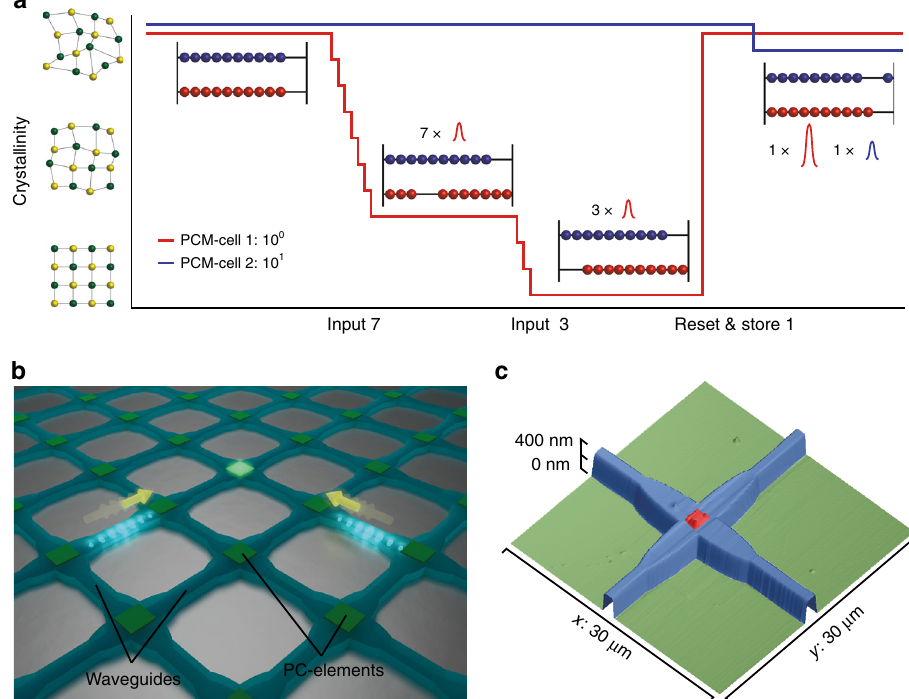
Fig. 1 All-optical arithmetic using phase-change nanophotonics. a Schematic of the operation principle of the photonic abacus. Two phase-change cells are switched with optical pulses in several steps from amorphous to crystalline, each level representing a digit in the decimal system. The red line corresponds to the level of crystallinity of the fi rst PCM-cell (representing ones) and the blue line to the second PCM-cell (representing tens). A reset to the initial state is induced by a higher power pulse. Applying the same crystallization pulses again, all intermediate levels can reproducibly be accessed. The example illustrates the addition ‘ 7 + 3 = 10 ’ , including carryover to a second phase-change cell. b Sketch of a waveguide crossing array illustrating the two-pulse addressing of individual phase-change cells. Only overlapping pulses provide suf fi cient power to switch a desired PCM-cell. c Atomic force microscopy image of a single crossing, with a footprint of 17 ´ 17 µ